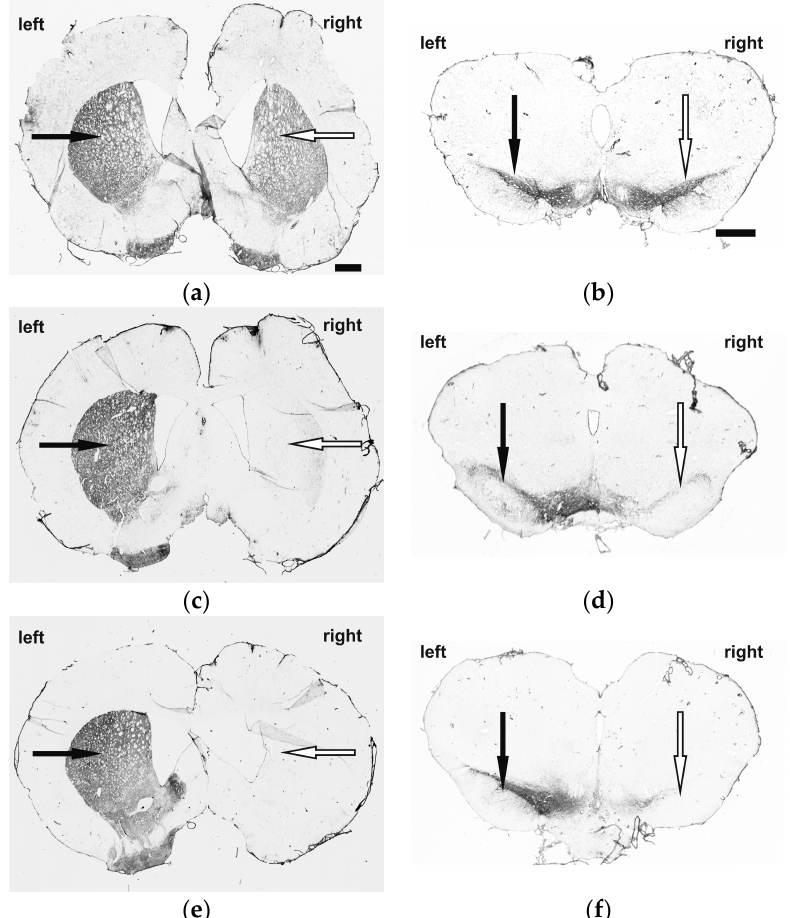
Figure 1. TH-immunoreactivity in the telencephalon (left column) and the mesencephalon (right column) of ( a , b ) controls (sham-6-OHDA + sham-BoNT-A) ( c , d ) sham-injected hemi-PD rats (6-OHDA + sham-BoNT-A) and ( e , f ) BoNT-A-injected hemi-PD rats (6-OHDA + BoNT-A). 6-OHDA or sham-6-OHDA was unilaterally injected into the MFB of the right hemisphere and BoNT-A was injected ipsilateral at two sites into the CPu. Controls showed symmetric TH pattern in the CPu ( a , c , e ; black ( left ) and white ( right ) arrow) and SN ( b , d , f ; black ( left ) and white ( right ) arrow), sham-injected hemi-PD rats demonstrated an almost complete loss of TH-positive cells in the CPu and SN and BoNT-A injection did not influence these findings in hemi-PD rats. The scale bar applies for a – f = 1 mm. Asymmetric rotations of hemi-PD rats were tested using apomorphine- and amphetamine-induced rotations one month after 6-OHDA lesion. Also, the positive